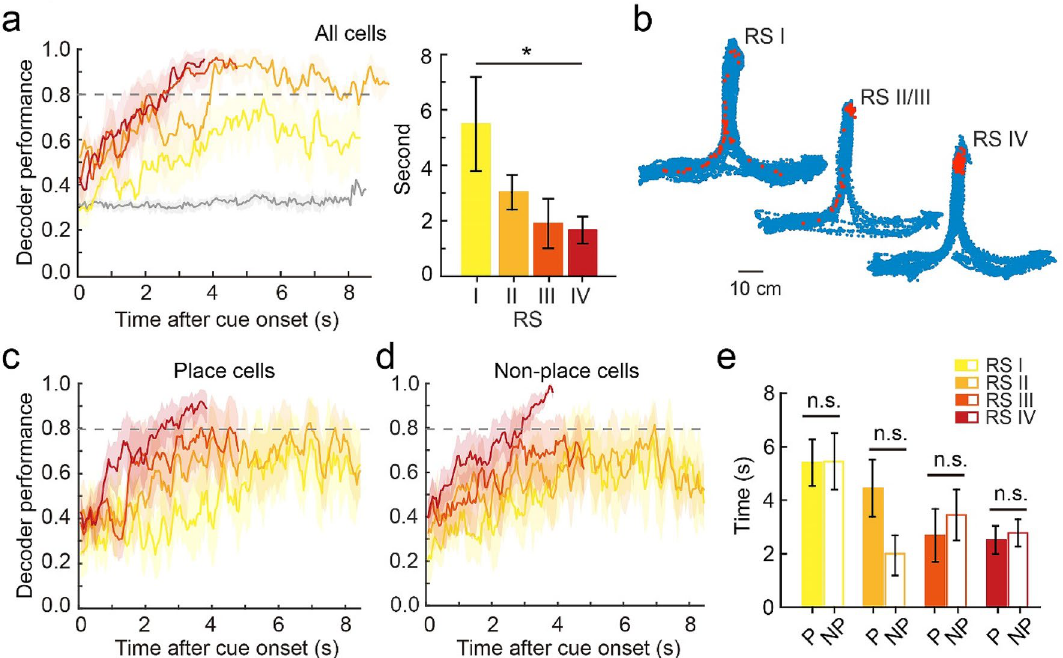
Figure 5. Activity of DGC ensembles represents auditory decisions. ( a ) Left, decoder performance in each frame after cue onset in each learning RS showing the maximum frame number per trial for each rat (gray line indicates the shuffled data in RS I). Right, quantification of frames needed to reach 80% decoder performance after cue onset (n = 5, Wilcoxon signed-rank test, mean ± SEM, * P < 0.05). ( b ) Trajectory with decoder location in each RS (blue: rat’s location across the entire session, red: rat’s location at the frame with 80% decoder performance). ( d , e ) Place-coding and non-place-coding decoder performance. ( e ) Quantification of frames needed to reach 80% decoder performance after cue onset using only place-coding (P) or non-place-coding (NP) cells (n = 5 rats, mean ± SEM, Wilcoxon signed-rank test, n.s., P >